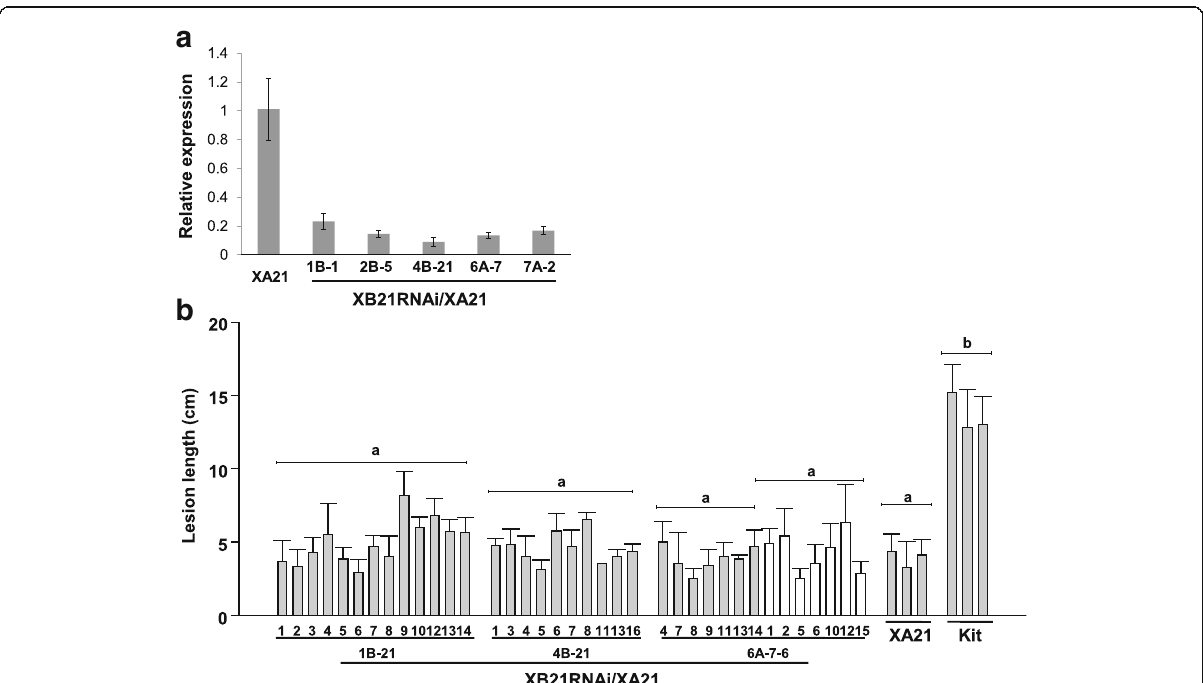
Fig. 6 Silencing of XB21 in XA21 transgenic plants does not affect resistance to Xoo. a Relative expression of XB21 in XA21 transgenic plants silencing XB21 . qRT-PCR was performed with specific primers for each genes. Gene expression level was normalized using ubiquitin as an internal reference. b Lesion lengths measured 12 days after inoculation from XA21 transgenic plants silencing XB21 (XB21RNAi/XA21 1B-21, 4B-21, and 6A-7-6) and XA21 transgenic plants (23A-1-14). Progeny not carrying XB21RNAi construct are labeled with a white bar . The error bars represent standard deviation values obtained from the two to seven samples from each